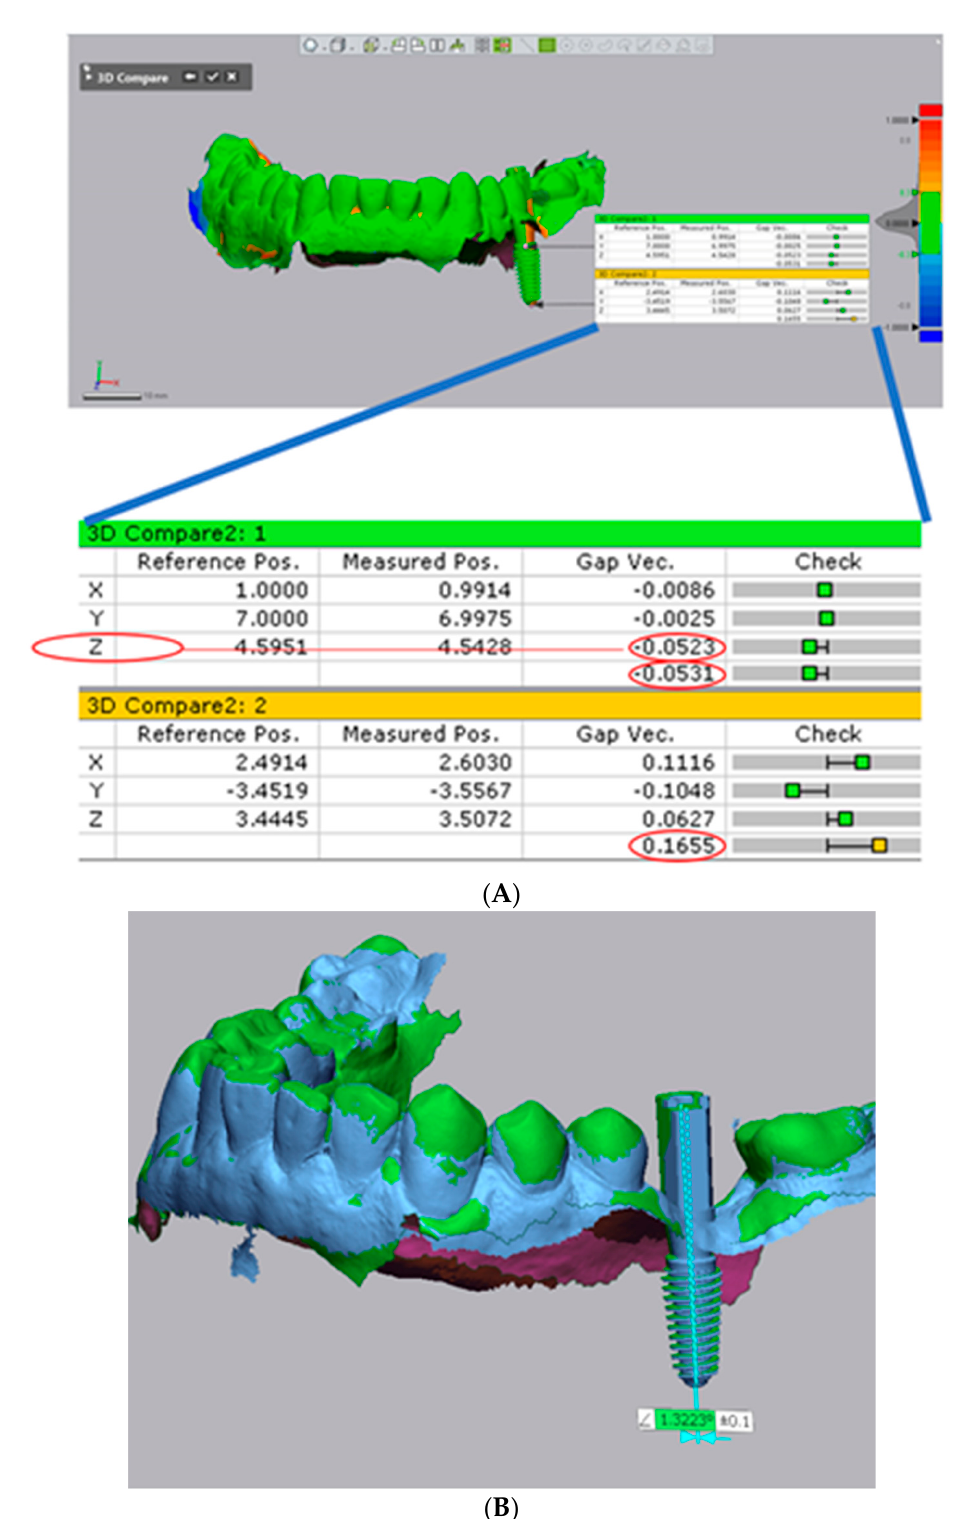
Figure 7. Trueness measurements in Geomagic Control X. ( A ) The displayed data were registered for assessment. ( B ) Measurement of angular deviation.